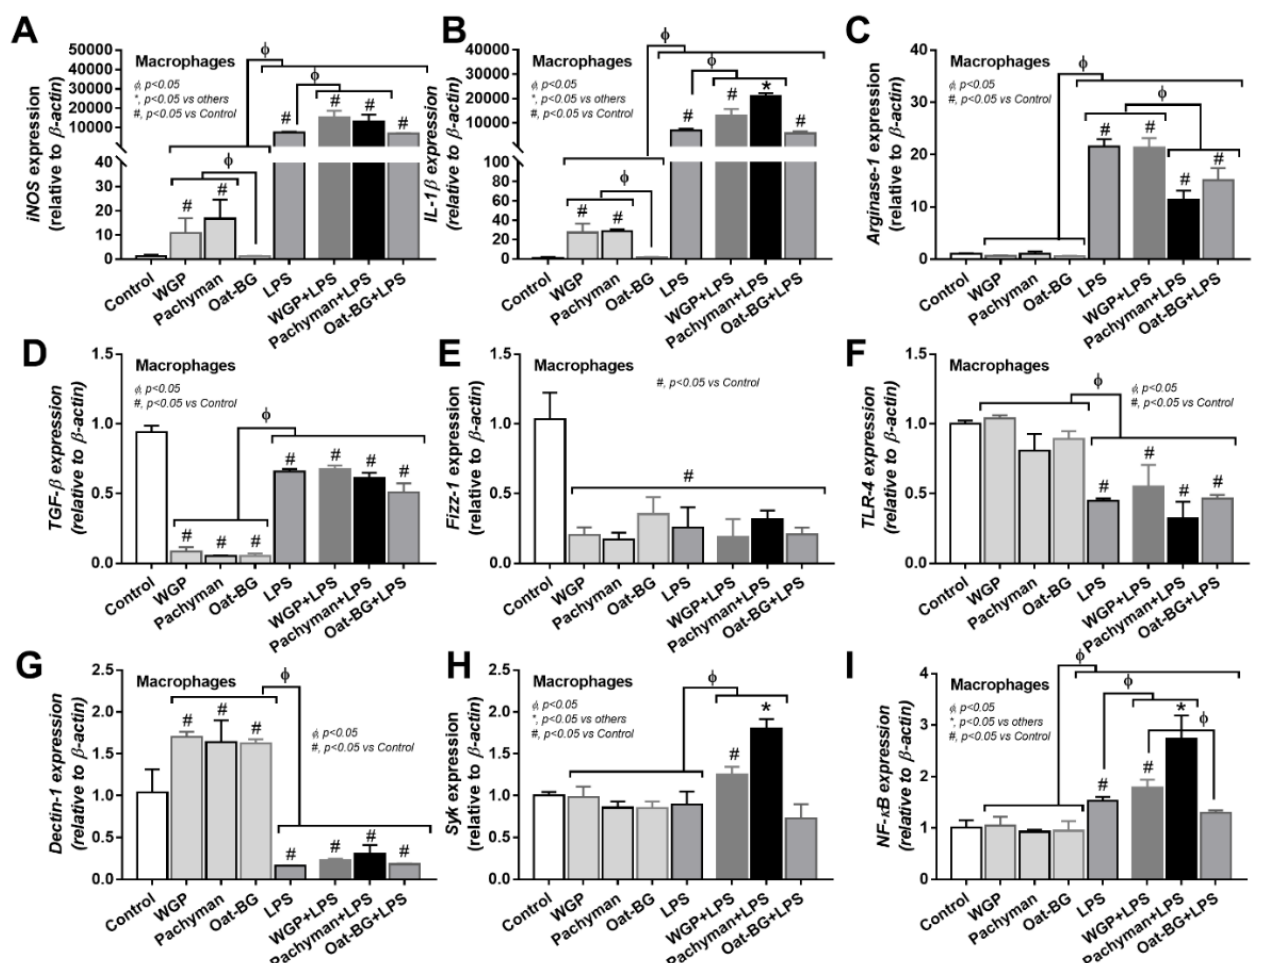
Figure 7. Gene expression characteristics of bone marrow-derived macrophages after 24 h of incu- bation in the control medium (Control) or supplemented with whole-glucan particles (WGP), Pachyman, Oat glucans (Oat-BG), lipopolysaccharide (LPS), and LPS with the different glucans. Pro- ( iNOS and IL- 1β ) and anti- inflammatory responses ( Arginase-1 , TGF- β , and Fizz-1 ) ( A – E ) with the signaling genes ( TLR-4 , Dectin-1 , Syk , and NF- κB ) ( F – I ) are shown ( n = 6 – 8/group). #, p < 0.05 vs. Control; *, p < 0.05 vs. other groups; ϕ , p < 0.05 vs. the indicated group as calculated by ANOVA with Tukey’s analysis. Independent triplicate experiments were performed.